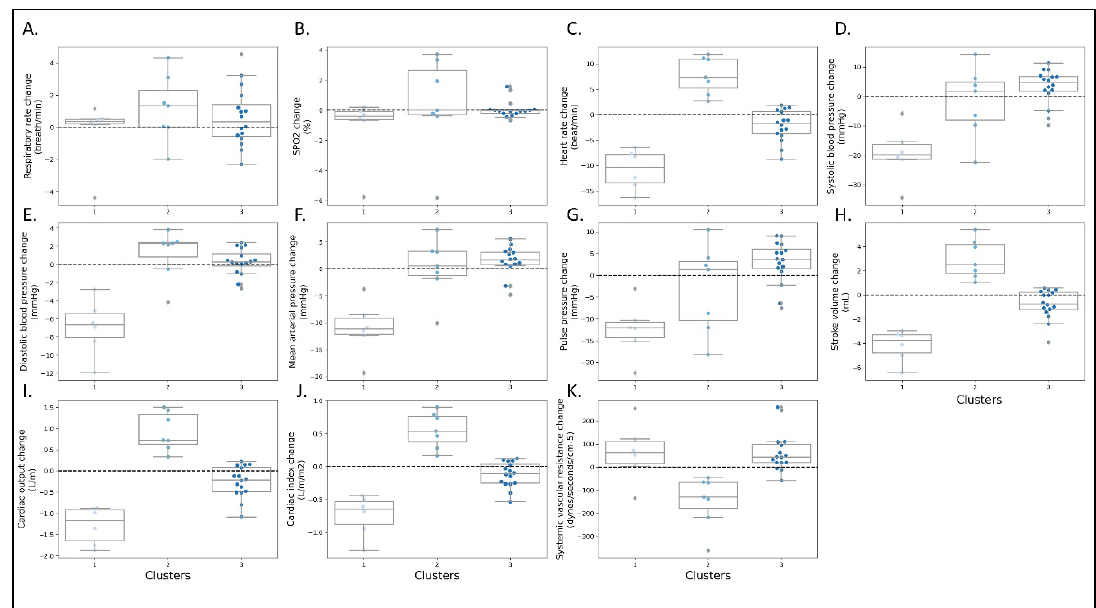
Figure 5. Relative changes from baseline in measured parameters from baseline to the fourth quartile of intravenous treatment in the three phenotypic clusters. ( A ) respiratory rate (RR), ( B ) blood oxygen saturation (SpO 2 -%), ( C ) systemic vascular resistance (dynes/sec/cm −5 ), ( D ) heart rate (beats per minute), ( E ) stroke volume (milliliters), ( F ) cardiac output (liter/minute), ( G ) cardiac index (liter/minute/body surface area), ( H ) systolic blood pressure (mmHg), ( I ) diastolic blood pressure (mmHg), ( J ) pulse pressure (mmHg), ( K ) mean arterial pressure (mmHg).